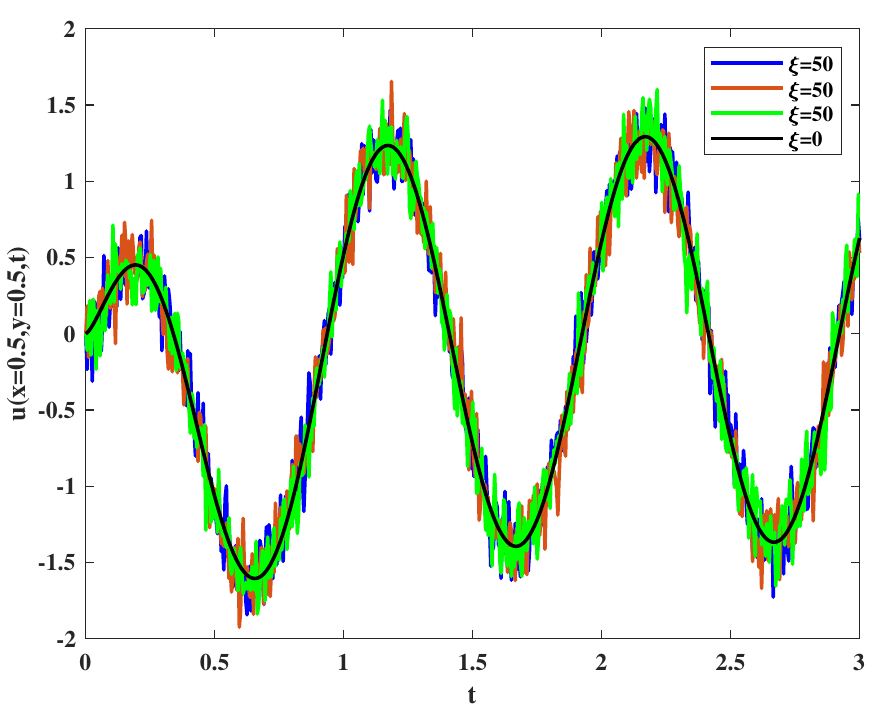
Figure 8. Velocity varies with different Brown paths.